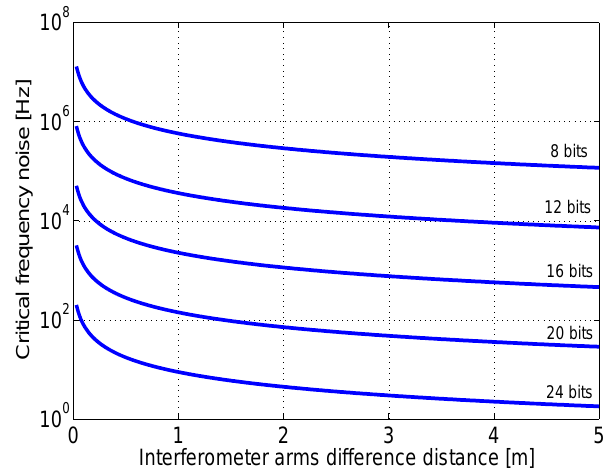
Figure 2. Length difference between the measuring and reference arms of the interferometer and corresponding limiting level of frequency fluctuations for 532 nm wavelength. (resolutions of the A/D conversion from top: 8, 12, 16, 20, 24